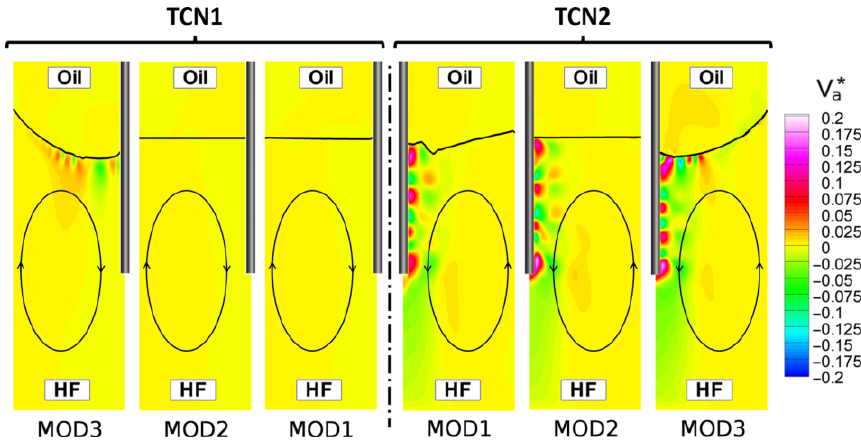
Figure 3. Contours of non-dimensional axial velocity: comparison between three different numerical models, referred to as MOD1, MOD2, and MOD3. The interface surface between oil and HF is highlighted.